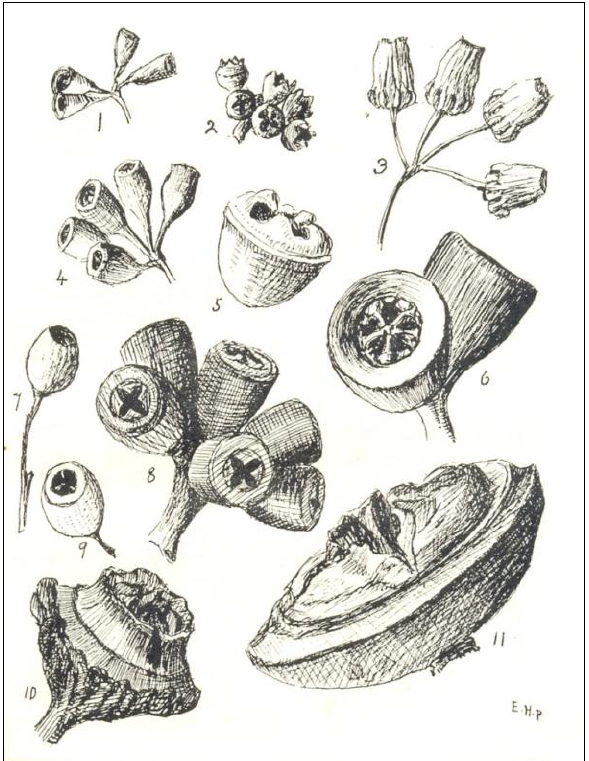
Figure 5. Sketch of eleven different gum nuts from Emily Pelloe’s Wildflowers of Western Australia